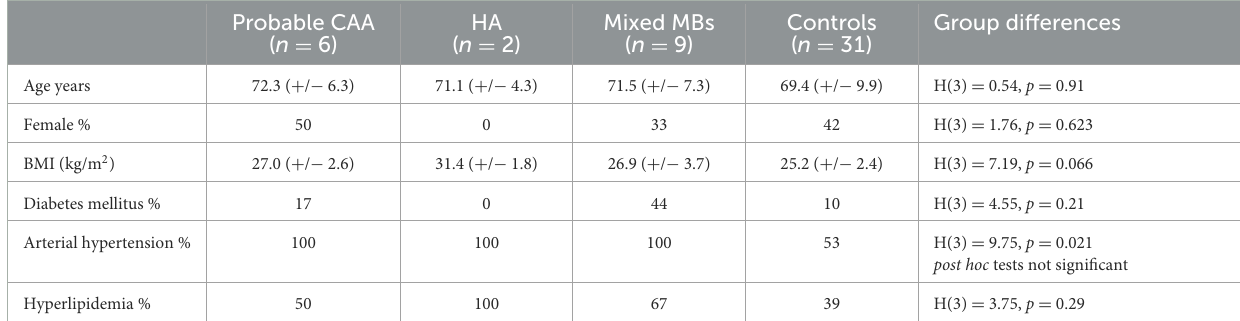
TABLE 1 Characteristics of the groups.